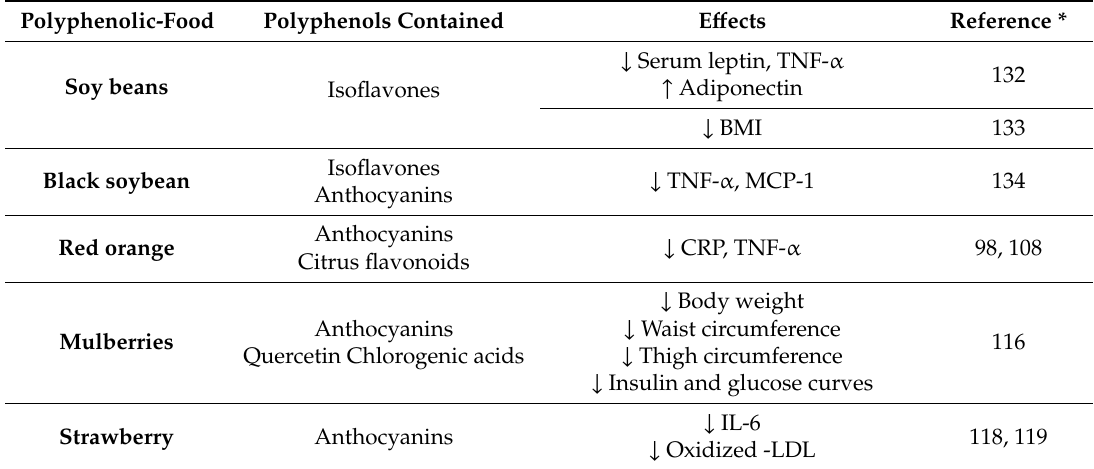
Table 2. Anti-obesity actions of some